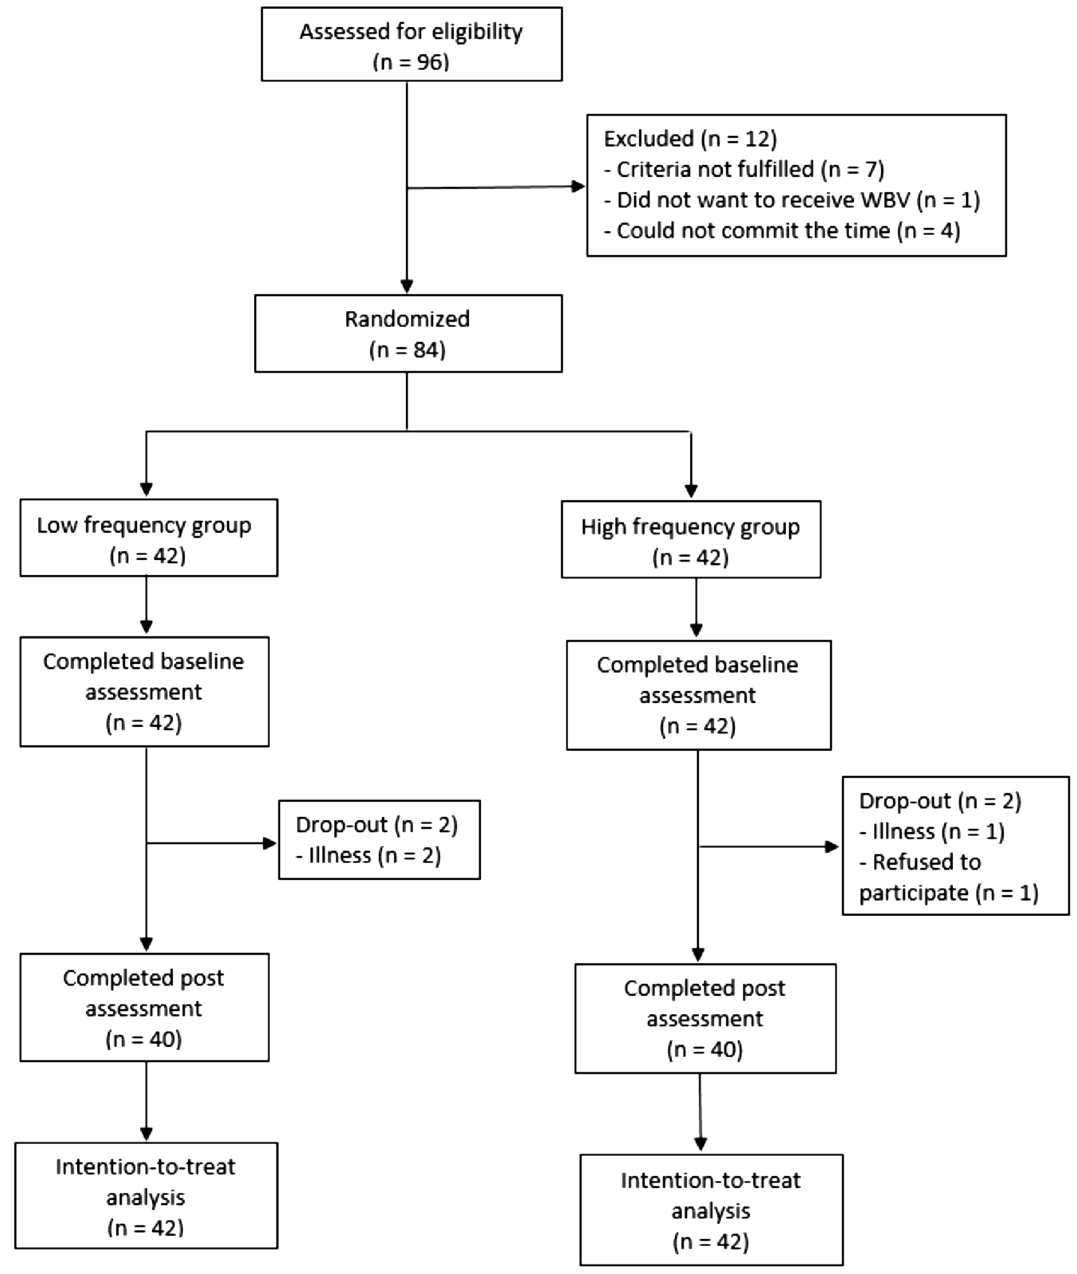
Figure 1. CONSORT flow